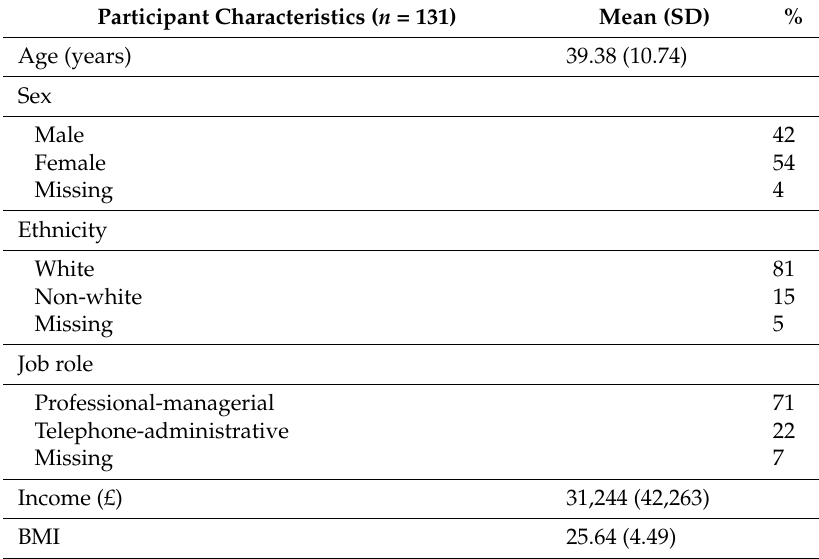
Table 2. Participant